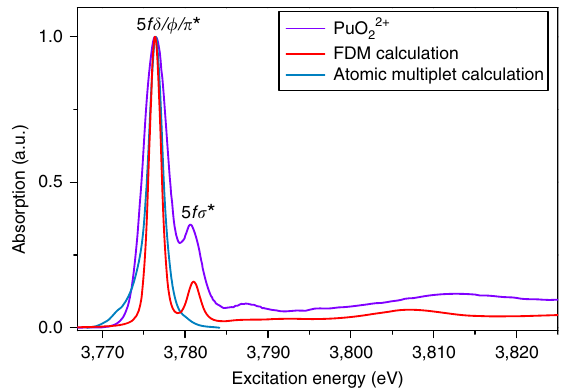
Figure 6 | Calculated and experimental Pu M 5 HR-XANES spectra. Pu M 5 absorption edge HR-XANES experimental and calculated spectra of PuO 2 2 þ in 1M HClO 4 , The atomic multiplets are from a full relativistic treatment of initial and final states with the DIRAC code 21 ; the FDM calculations are performed with the FDMNES code 22